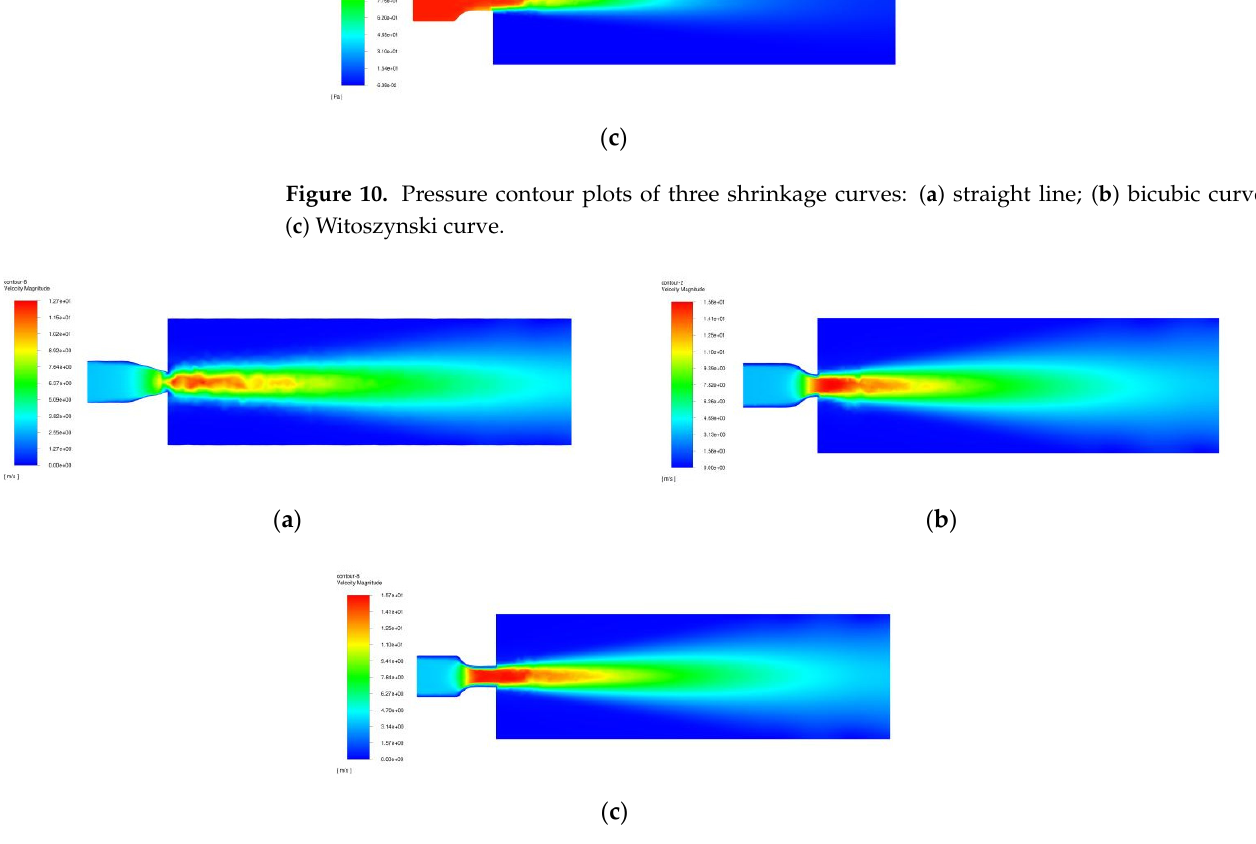
Figure 11. Velocity contour plots of three shrinkage curves: ( a ) straight line; ( b ) bicubic curve; ( c ) Witoszynski curve.